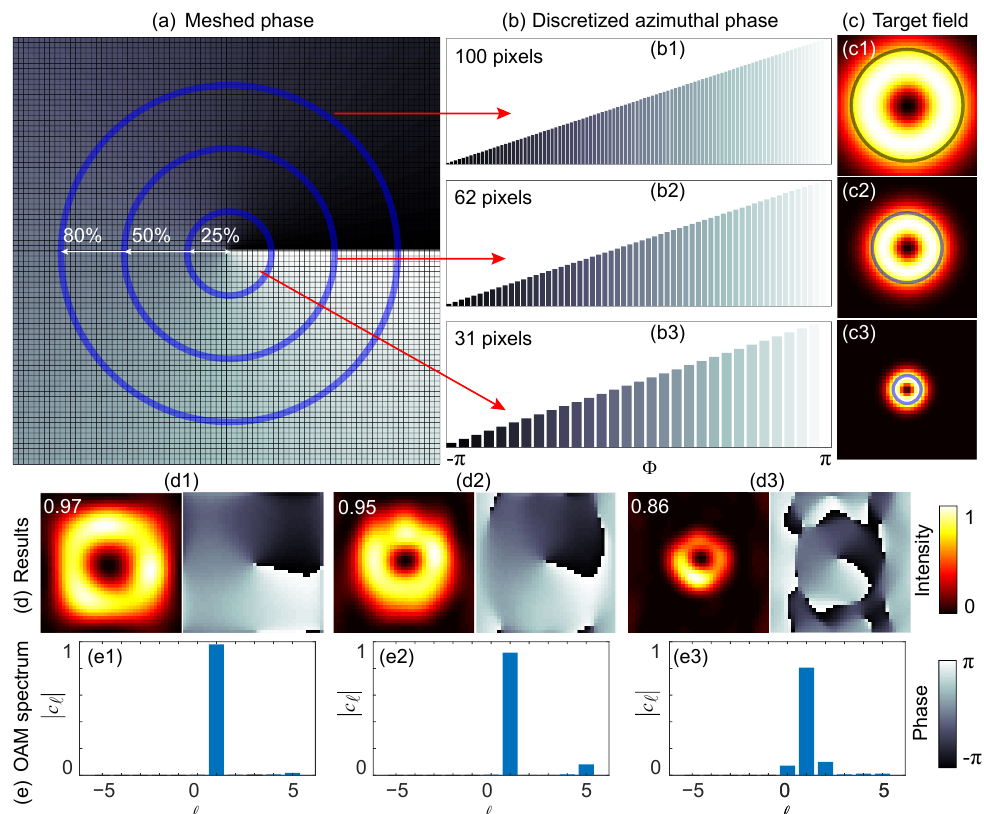
Figure 4. Schematic of reconstructed vortex beam under discretized azimuthal phase. ( a ) The phase sampling in a finite resolution ( 40 × 40 ) phase diagram, ( b ) the discretized azimuthal phase with different pixels, ( c ) intensity of the vortex light field with different radii, where ( d , e ) are the intensity, phase and OAM spectrum of the reconstructed field. ( b1 – e1 , b2 – e2 and b3 – e3 correspond to the optical field radius proportion of 25%, 50% and 80%, respectively, relative to the computational